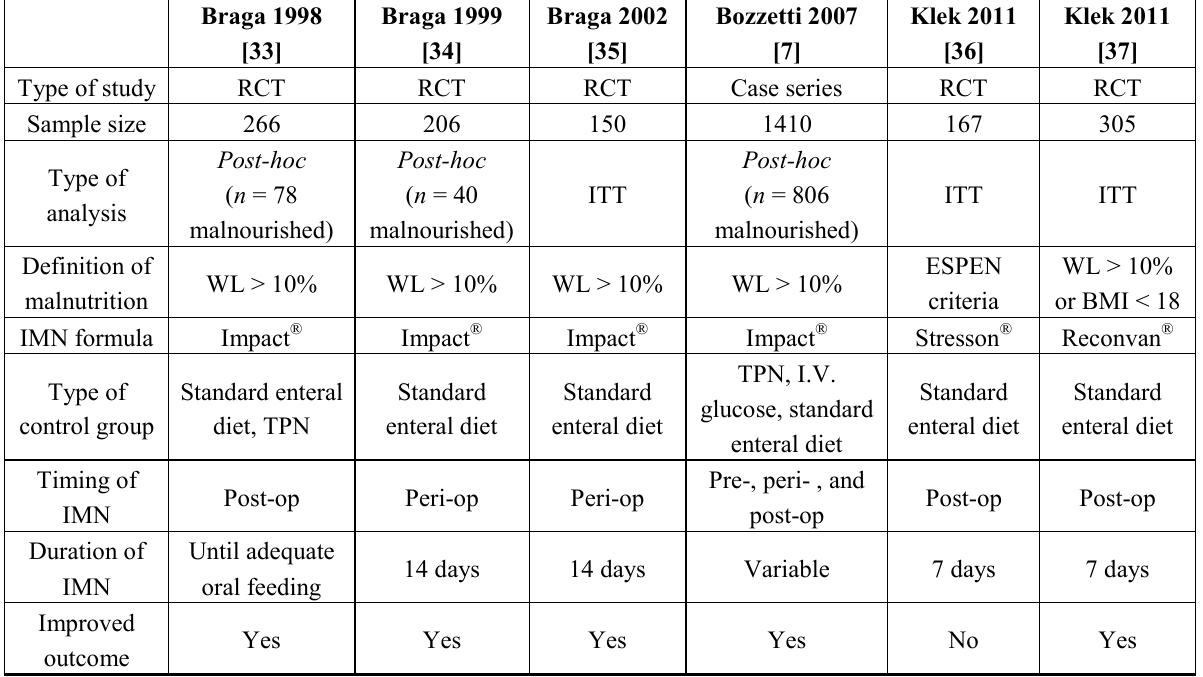
Table 2. Studies evaluating the effect of IMN in malnourished